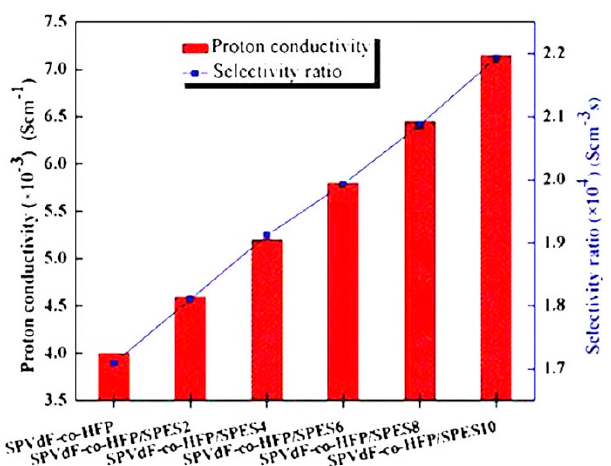
Figure 8. Proton conductivity and selectivity ratio of SPVdF- co -HFP and SPVdF- co -HFP / SPES blend membranes. Reproduced with permission from [74]. Copyright Elsevier, 2017.